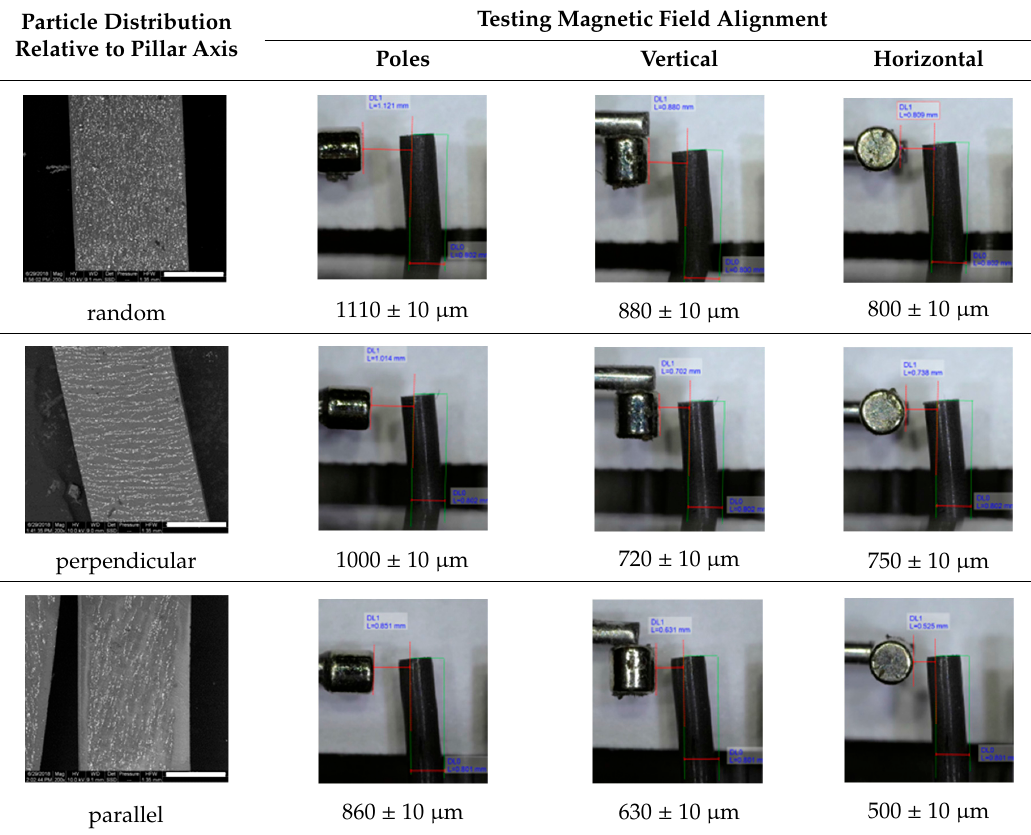
Table 1. Magnetic particle distribution and their maximum distance for bending response. Particle Distribution Relative to Pillar